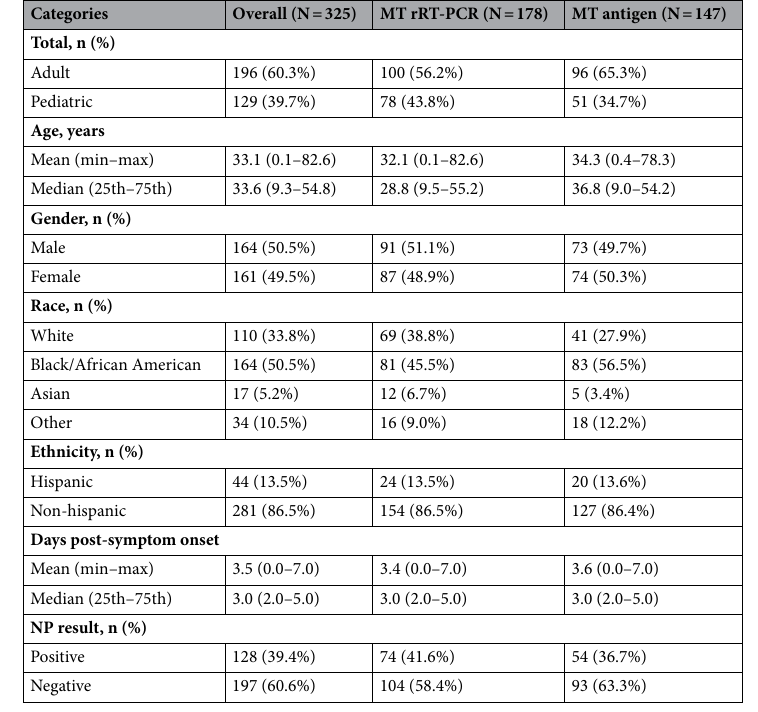
Table 1. Overall, MT rRT-PCR group and MT antigen group participant demographics. Missing: n = 1 for race/ethnicity (refused to answer).